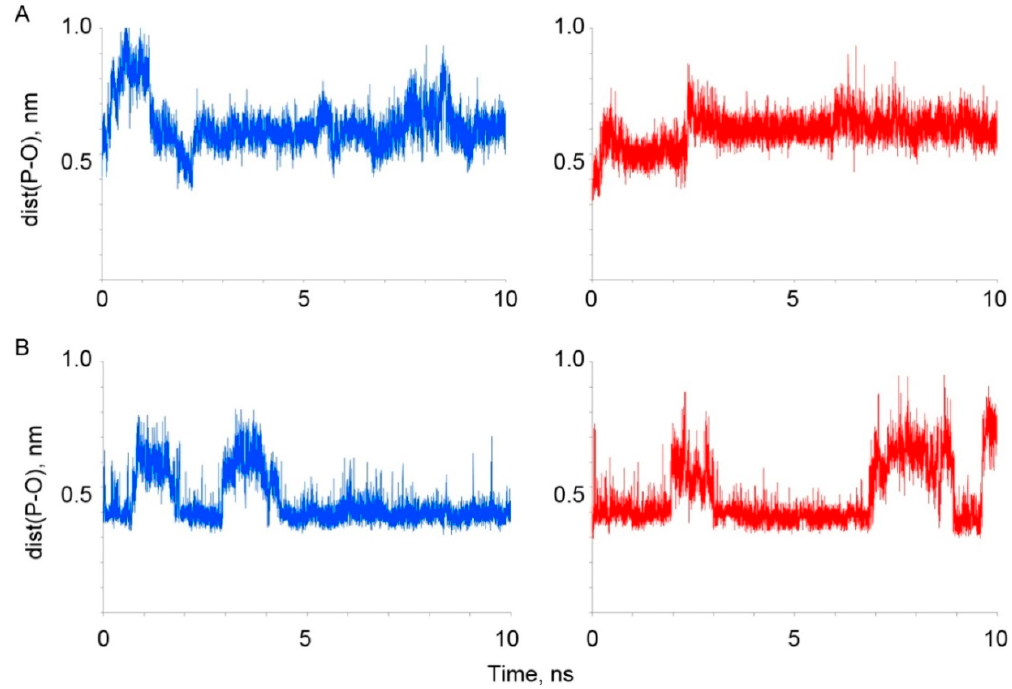
Figure 4. Time dependence of the distance between the phosphorus atom of paraoxon and the hydroxyl atom of Tyr150 (149) ( A ) and Tyr411 (410) ( B ) of HSA (blue) and BSA (red).